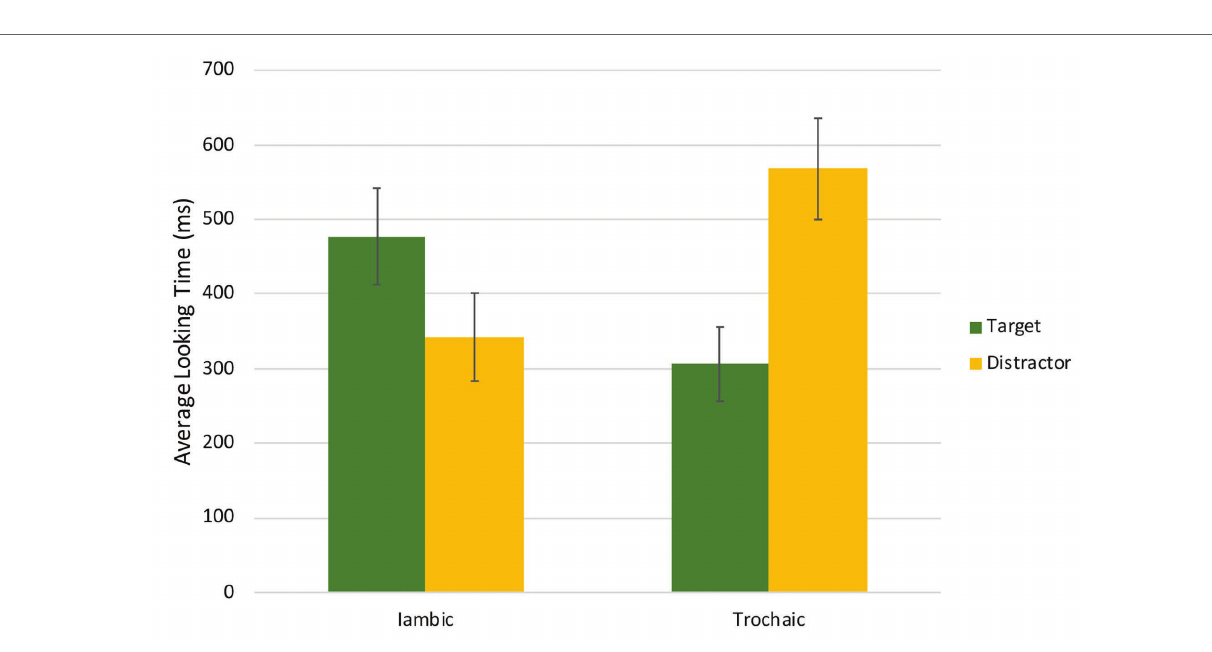
iambic and trochaic trained side during iambic and trochaic test trials. Overall, infants looked longer at the iambic trained side (517 ms) than at the trochaic side (323 ms). A 2 (Trained side) × 2 (Order) × 2 (Stimuli) ANOVA revealed a significant effect of trained side [ F (1,22) = 6.14, p = 0.02, η 2 p = 0.22], with no effect of Order [ F (1,22) = 3.10, p = 0.09, η 2 p = 0.12] or Stimuli [ F (1,22) = 1.74, p = 0.20, η 2 p = 0.07], and no significant interactions.